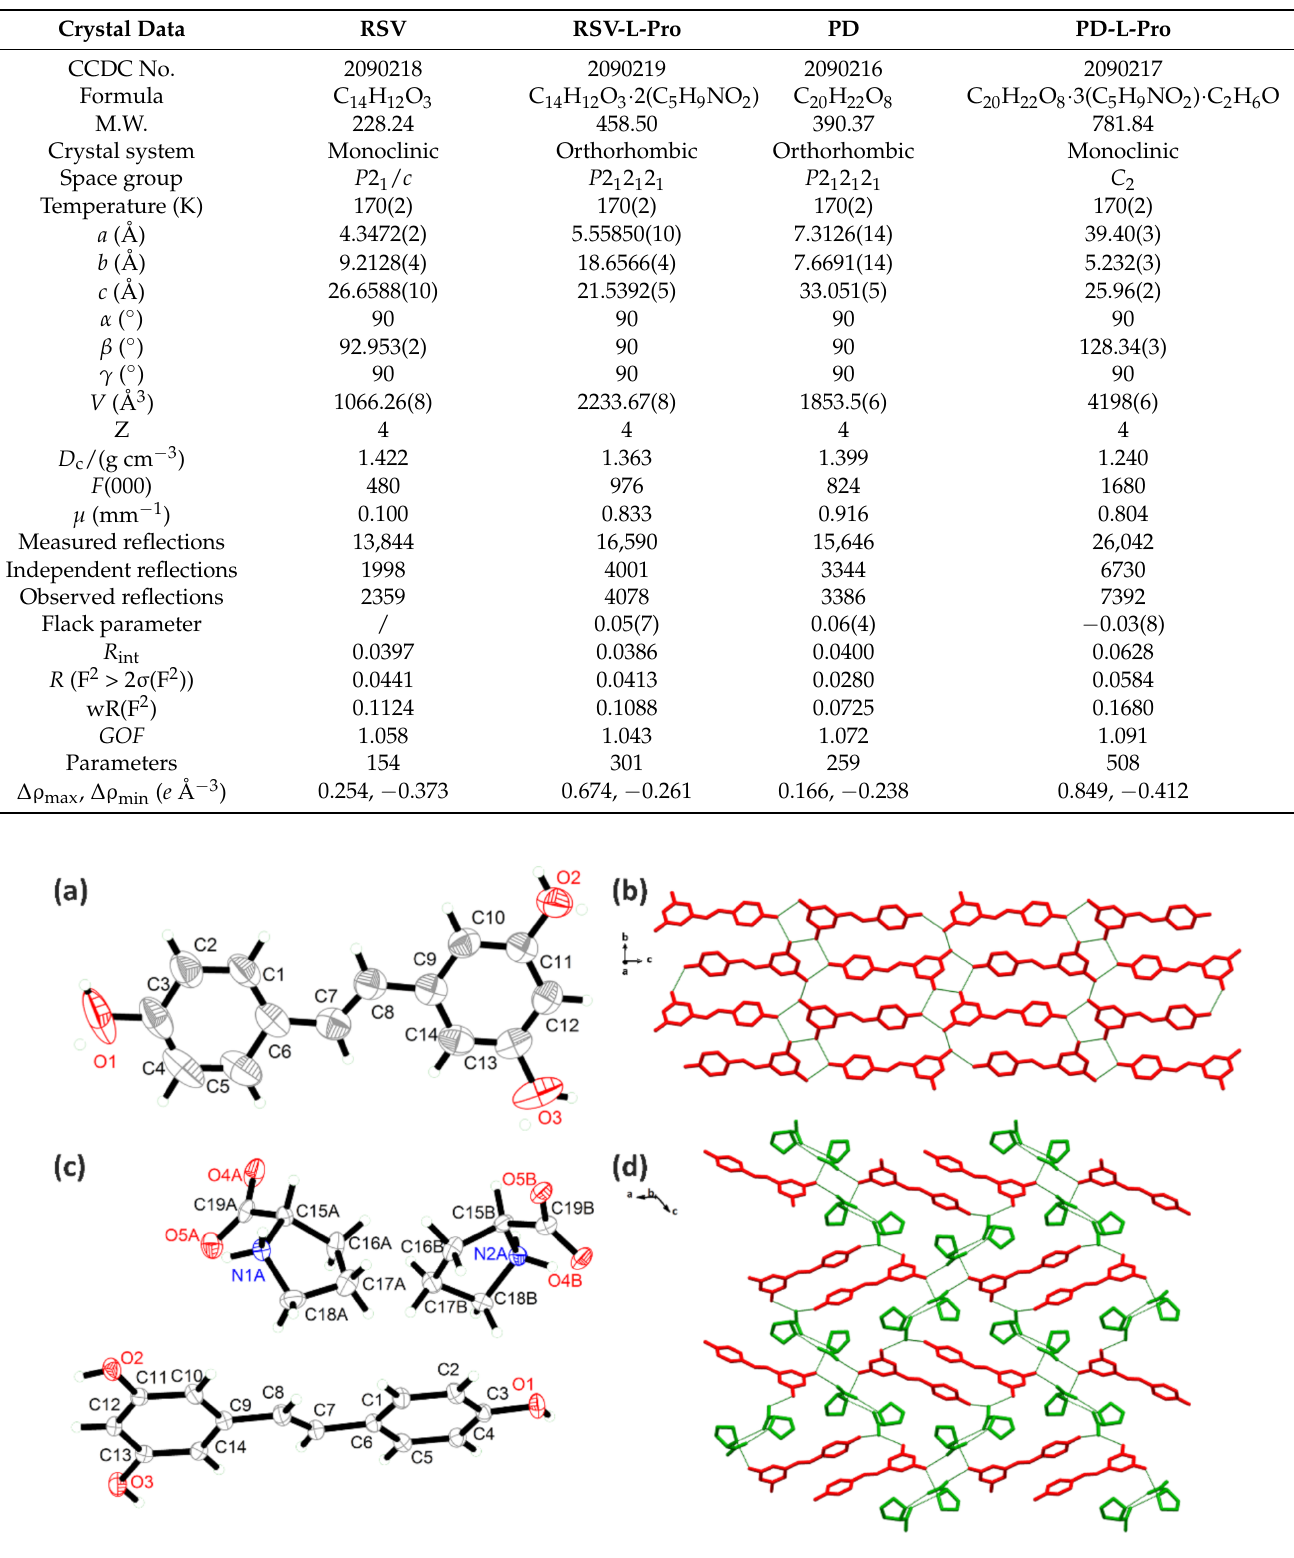
Figure 5. The asymmetric unit of RSV ( a ) and RSV-L-Pro ( c ), as well as their hydrogen-bonded network ( b , d